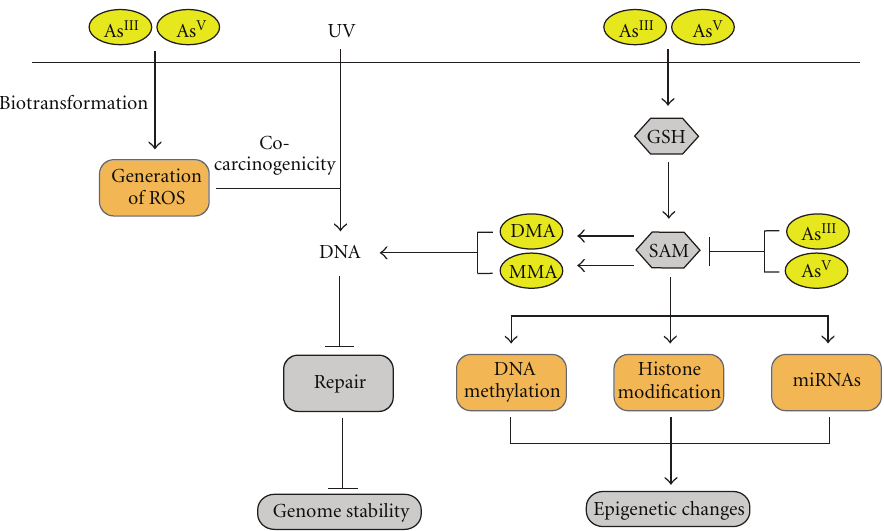
Figure 2: Schematic representation of proposed arsenic-induced carcinogenic mechanisms. Arsenic can enter cells in both tri- or pentavalent forms (As III or As V ). Inside cells, As V is converted to As III , with subsequent methylation to monomethylated (MMA) and dimethylated (DMA) species. The methylation of inorganic arsenic consumes both S-adenosylmethionine (SAM) and glutathione (GSH). Cellular damage derived from arsenic biotransformation can occur through generation of reactive oxygen species (ROS), and through epigenetic mechanisms: changes in DNA methylation patterns (by depletion of cellular pools of methyl group), histone modification, and altered expression of microRNAs